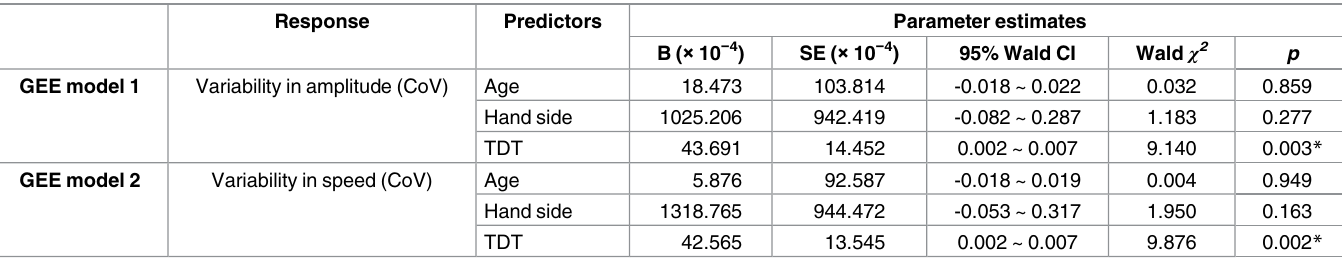
Table 3. Parameterestimatesof GEE models in PD patients showing relationship between TDT values and variabilities in amplitude and speed.